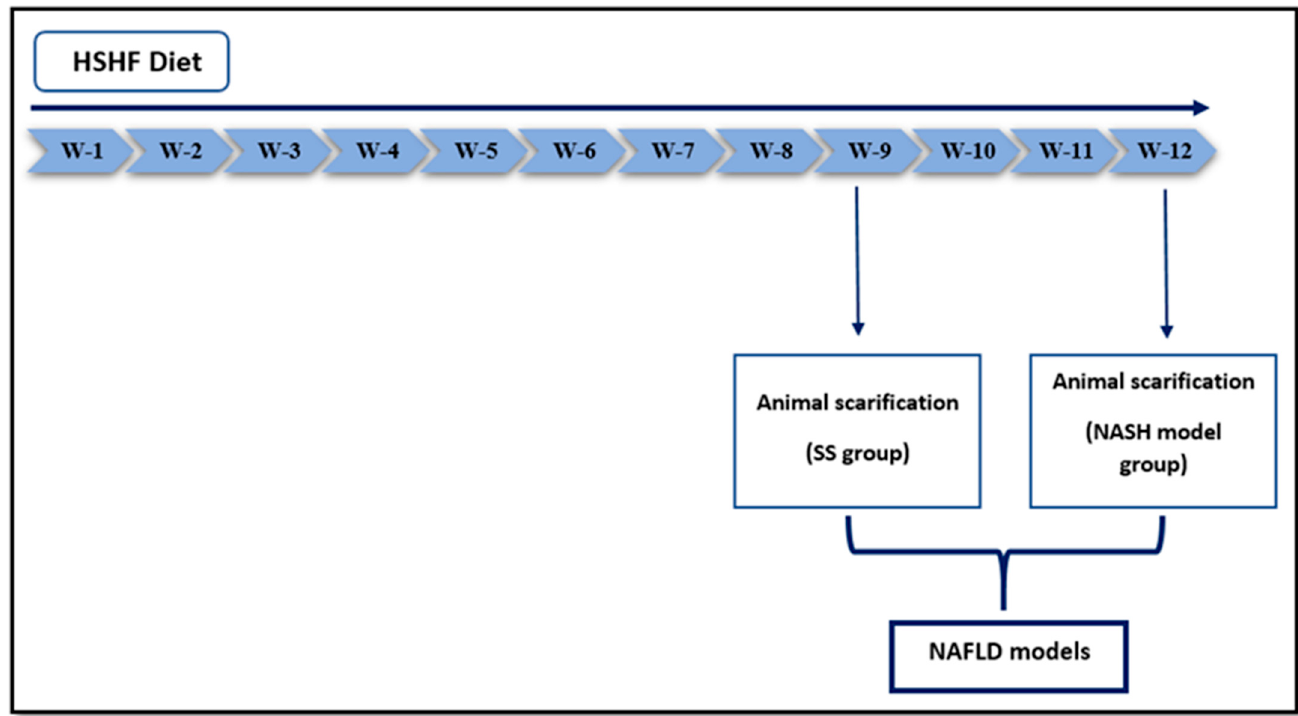
Figure 6. Timeline and study design. HSHF: high sucrose and fat diet; SS: simple steatosis; NASH: nonalcoholic steatohepatitis; NAFLD: nonalcoholic fatty liver disease.